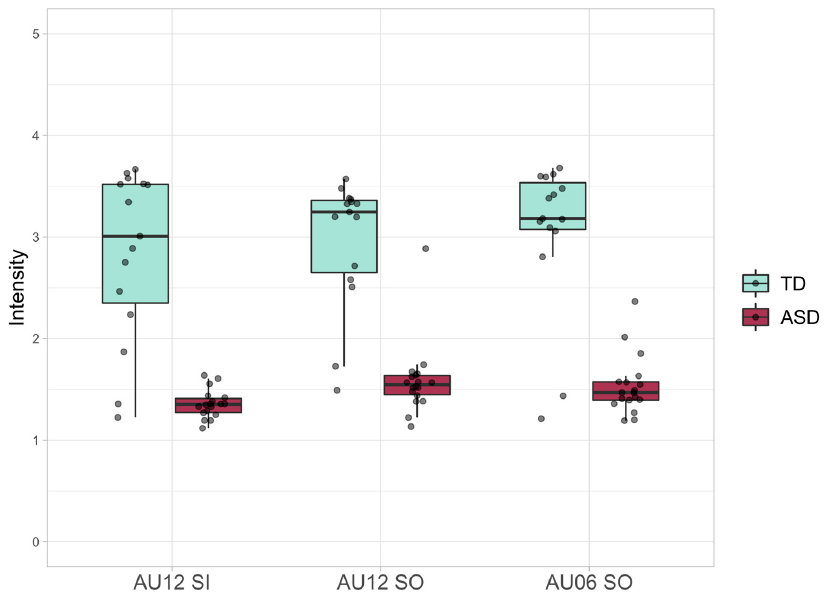
Figure 2. Smile Intensity; boxplots of Action Units 12 and 6 (AU12 and AU06) intensities for Social Smiles (SO) and Action Unit 12 (AU12) intensity for Simple Smiles (SI).